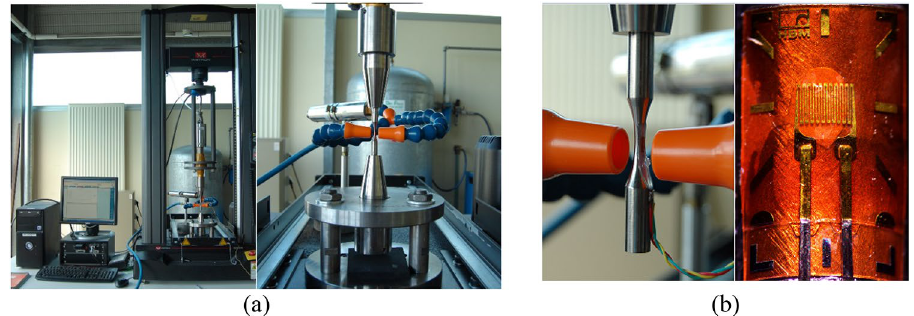
Fig. 2 Exterior view of VHCF testing machine ( a ) and ele- ments of the sample calibra- tion system ( b